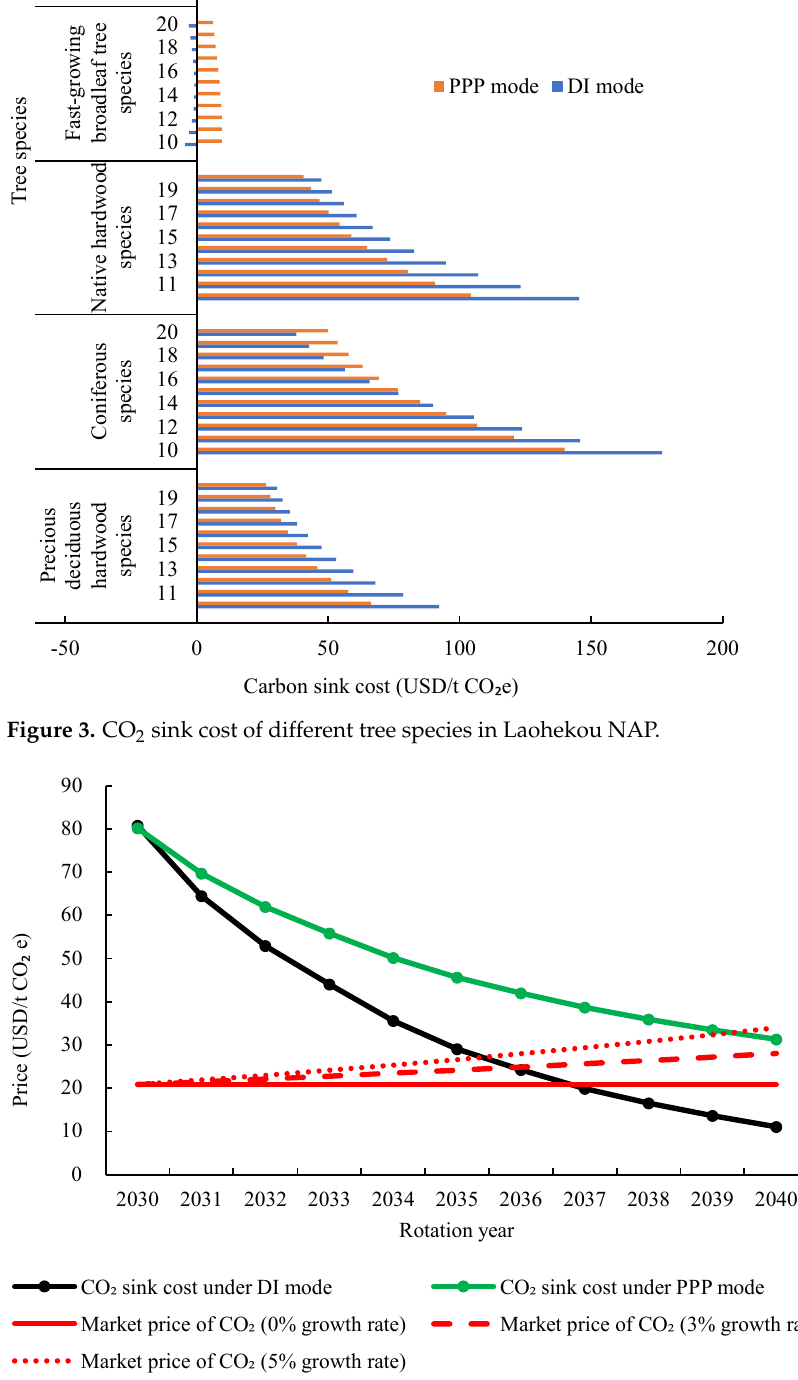
Figure 4. Sink cost and future market price of CO 2 in Laohekou NAP.